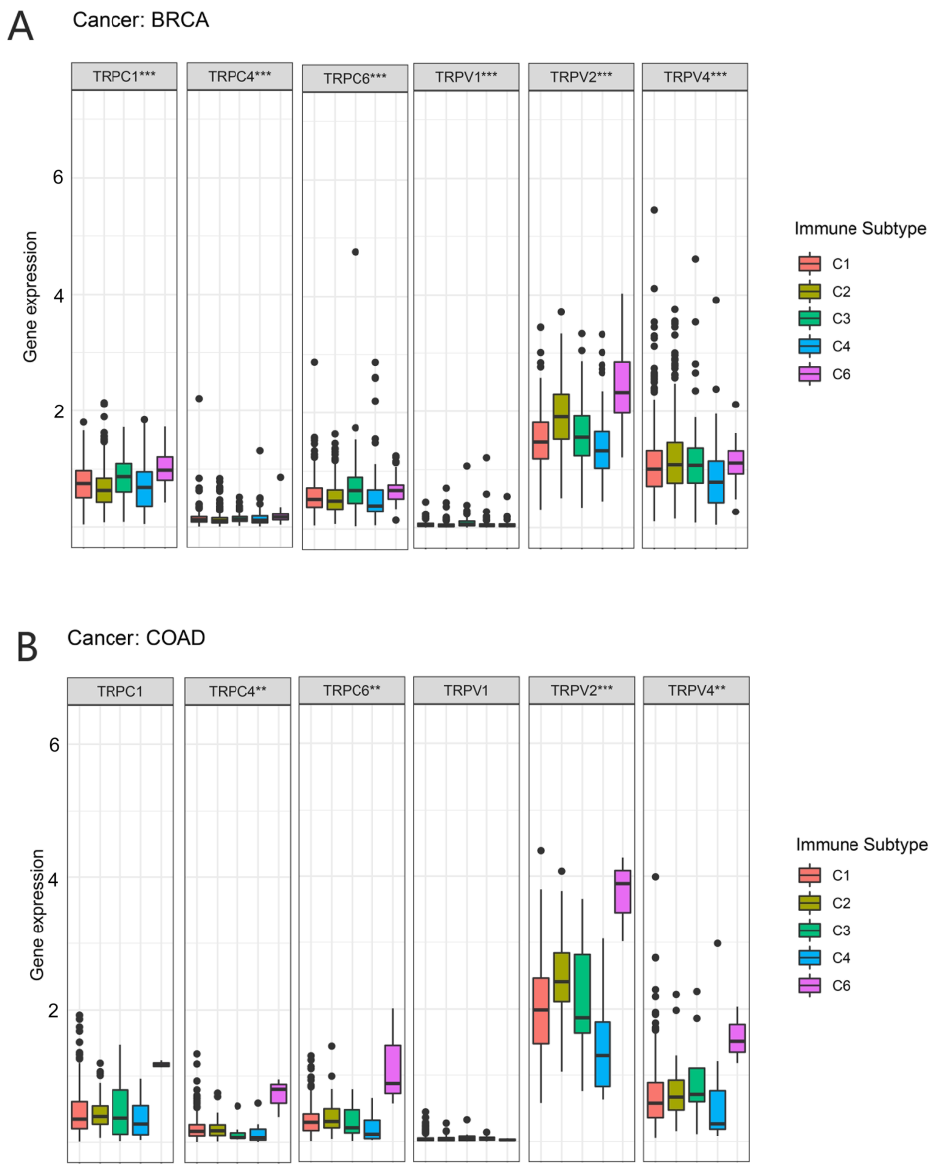
Figure 7. Correlation between the expression of TRP family genes and immune subtypes in BRCA and COAD. The significantly different expression of TRP family genes in various immune subtypes in ( A ) BRCA and ( B ) COAD. ( A ) TRPC1, TRPC4TRPC6, TRPV1, TRPV2, and TRPV4 were all differently expressed among the immune subtypes. ( B ) TRPC4TRPC6, TRPV2, and TRPV4 were differently expressed among the immune subtypes, especially the C6 subtype. X-axis represents immune subtype, and y-axis represents gene expression. C1, wound healing; C2, IFN-g dominant; C3, inflammatory; C4, lymphocyte depleted; C5, immunologically quiet; C6, TGF- β dominant. ** p < 0.01, and *** p <